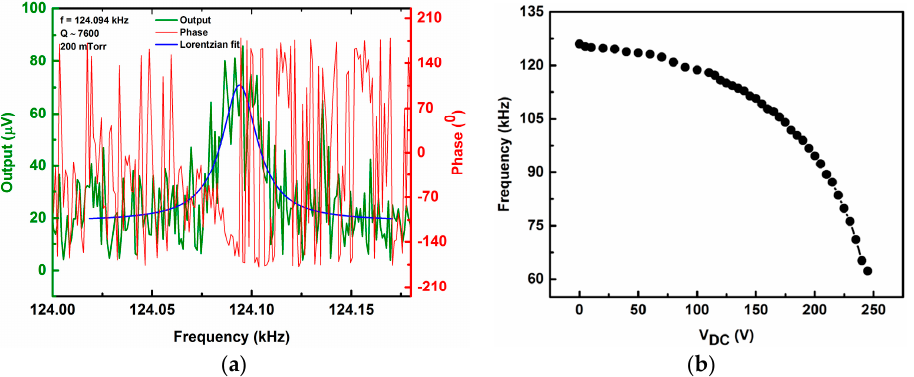
Figure 2. ( a ) The linear resonance frequency and phase response of the arch beam at V DC = 10 V and V AC = − 30 dBm. The magnitude curve is fitted with Lorentzian fit; ( b ) Theoretically predicted frequency response of the arch beam with applied direct current (DC) bias voltage.